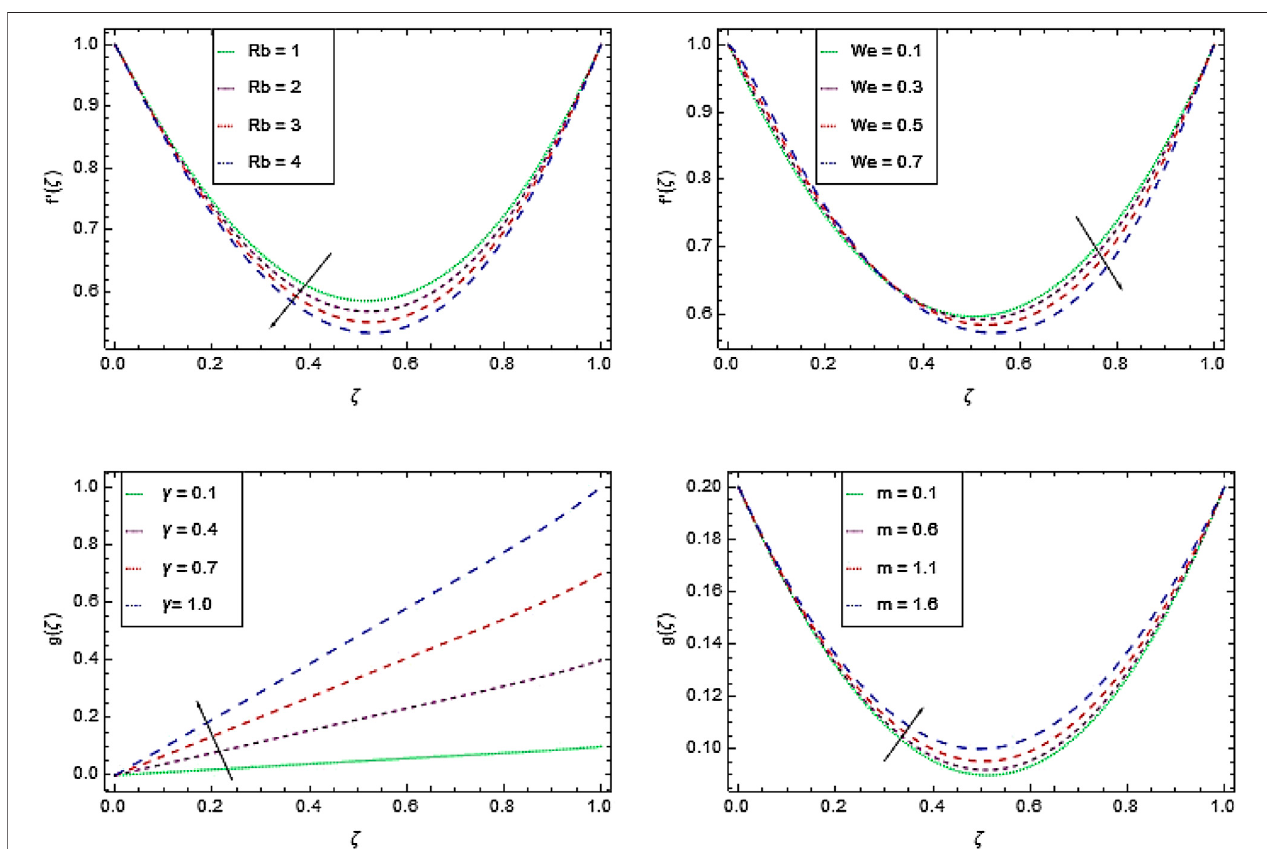
FIGURE 3 | f ′ ( ζ ) as a function of (A) Rb , (B) We , and g ( ς ) as a function of (C) c and (D) m .